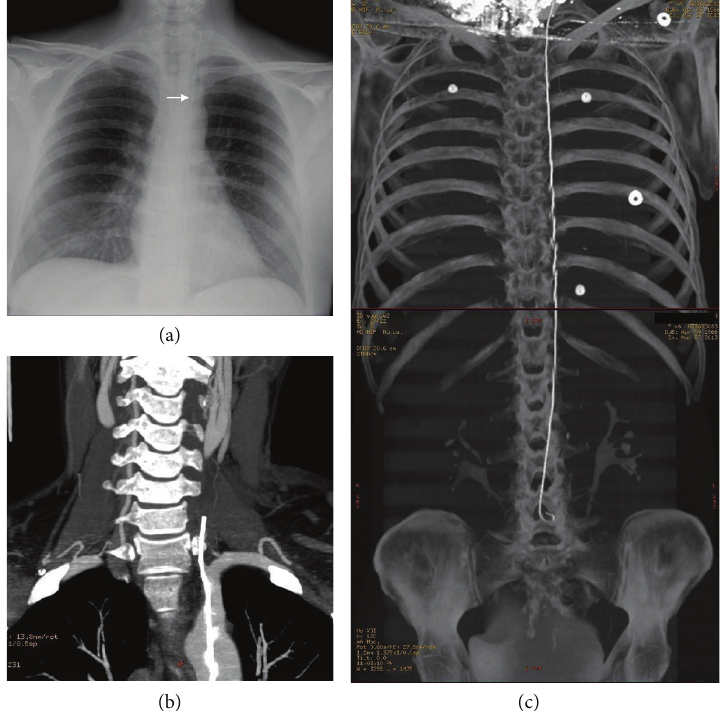
Figure 2: (a) Chest X-ray revealing the presence of the guide wire in the left hemithorax (arrow). (b) Cervical CT angiography showing insertion of the guide wire in the left subclavian artery, causing left vertebral artery occlusion, with the tip inserted in the superficial neck tissues. (c) Total body CT showing the vascular course of the guide wire as far as the distal abdominal